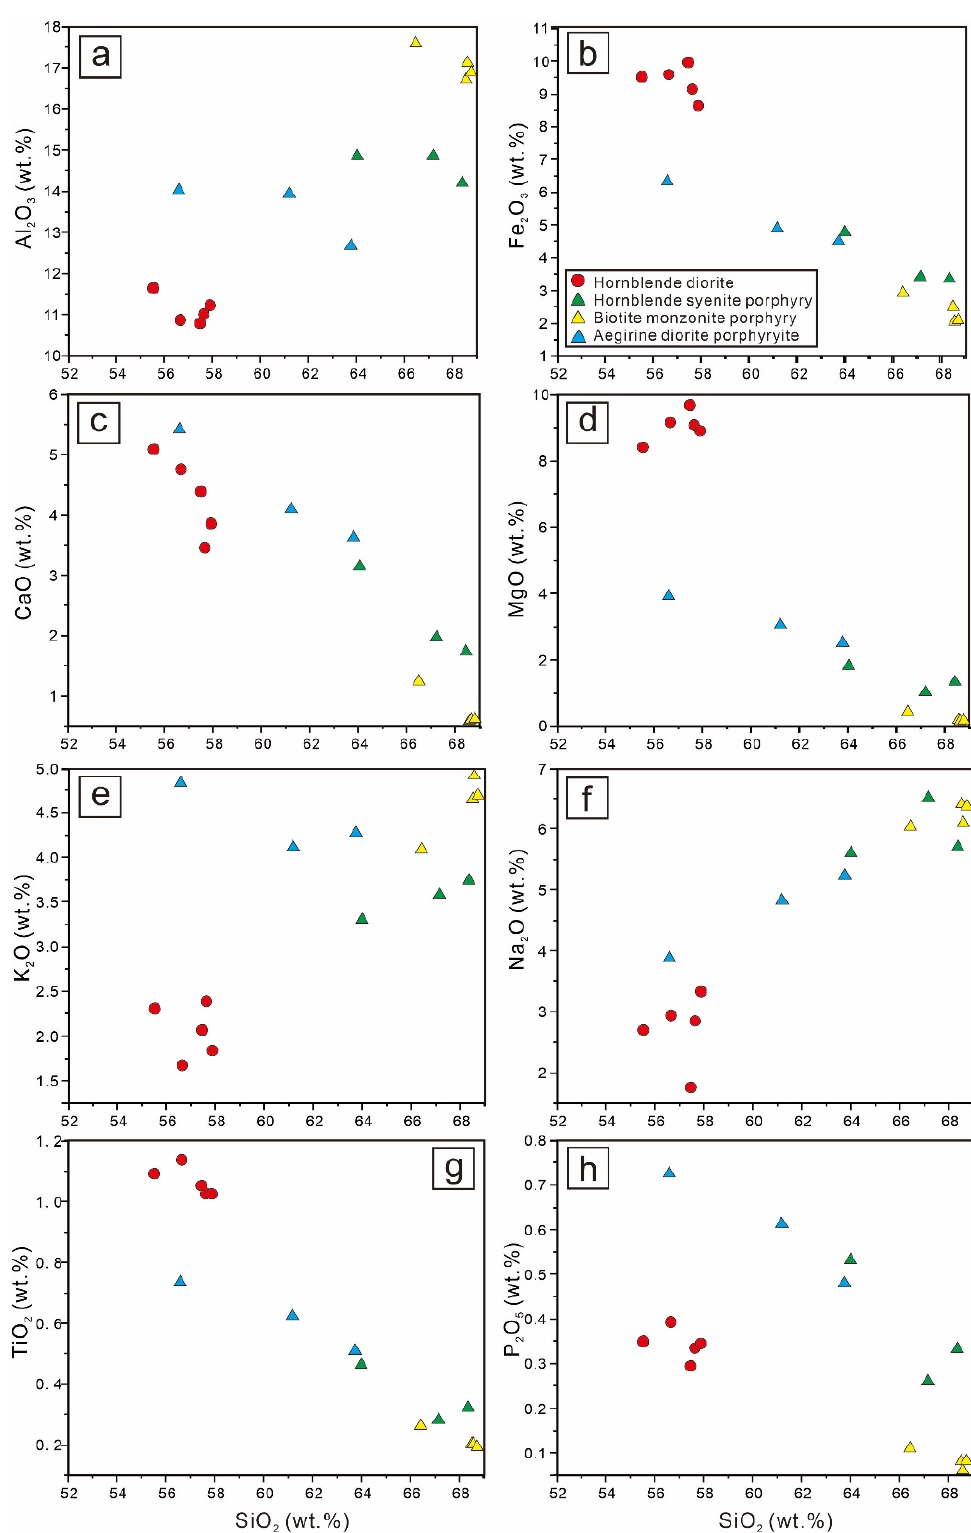
Figure 8. Harker diagrams for major elements of Longbaoshan alkaline complex. Figure 8. ( a – h ) Harker diagrams for major elements of Longbaoshan alkaline